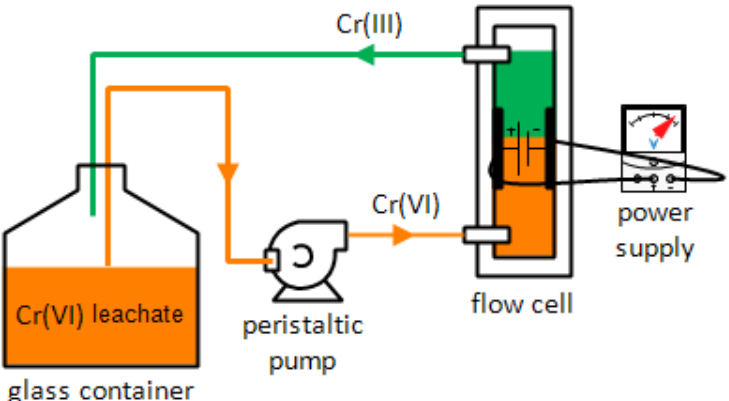
Figure 1. Flow diagram of the batch-recirculation prototype reactor experimental